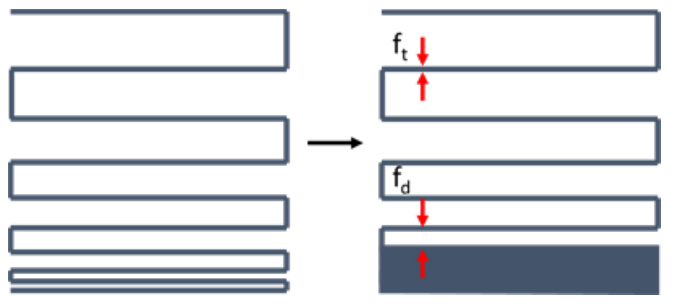
Figure 17. Single layered, meandered resolution tree for investigation of filament thickness (f t ) and filament distance (f d ).